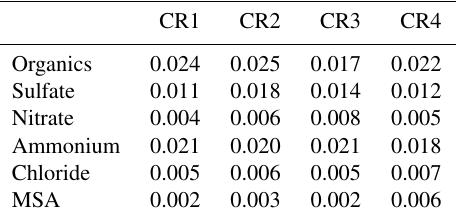
Table 2. The 20min detection limits during four Polarstern cruises (µgm − 3